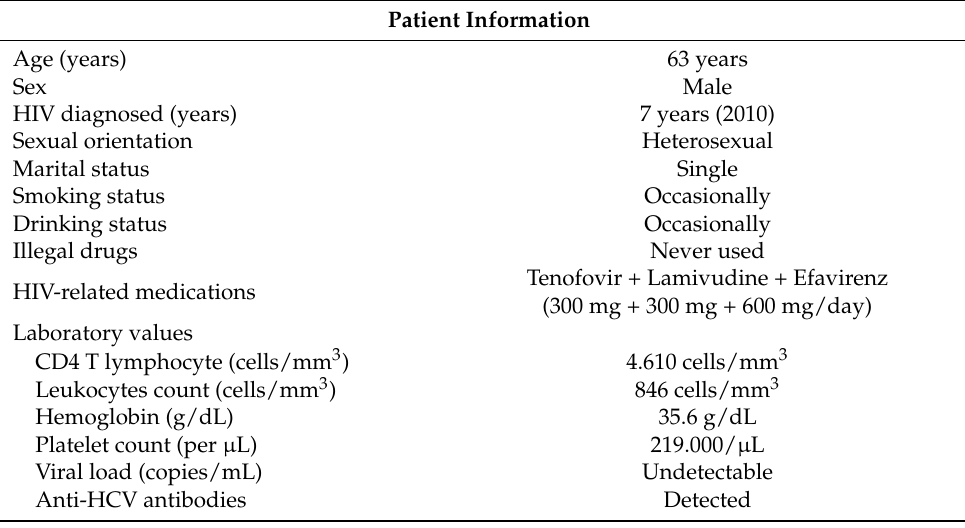
Table 1. Positive HCV genotype 2b patient’s medical